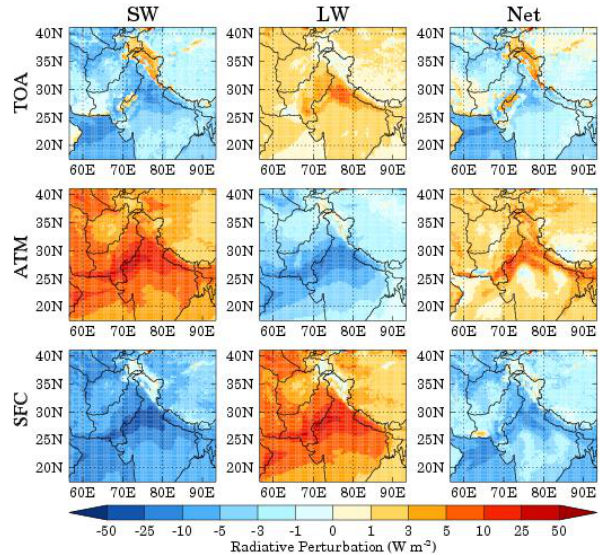
Fig. 11. Spatial distributions of diurnally averaged all-sky short- wave (SW), long-wave (LW) and Net (SW + LW) radiative per- turbation due to dust aerosols over the model domain from WRF- Chem simulations during 17–22 April 2010 at the top of atmosphere (TOA; top panels), in the atmosphere (ATM; middle panels) and at the surface (SFC; bottom panels). Positive values refer to an overall warming effect and negative values refer to an overall cooling effect. Radiative perturbation is calculated using two parallel simulations with and without